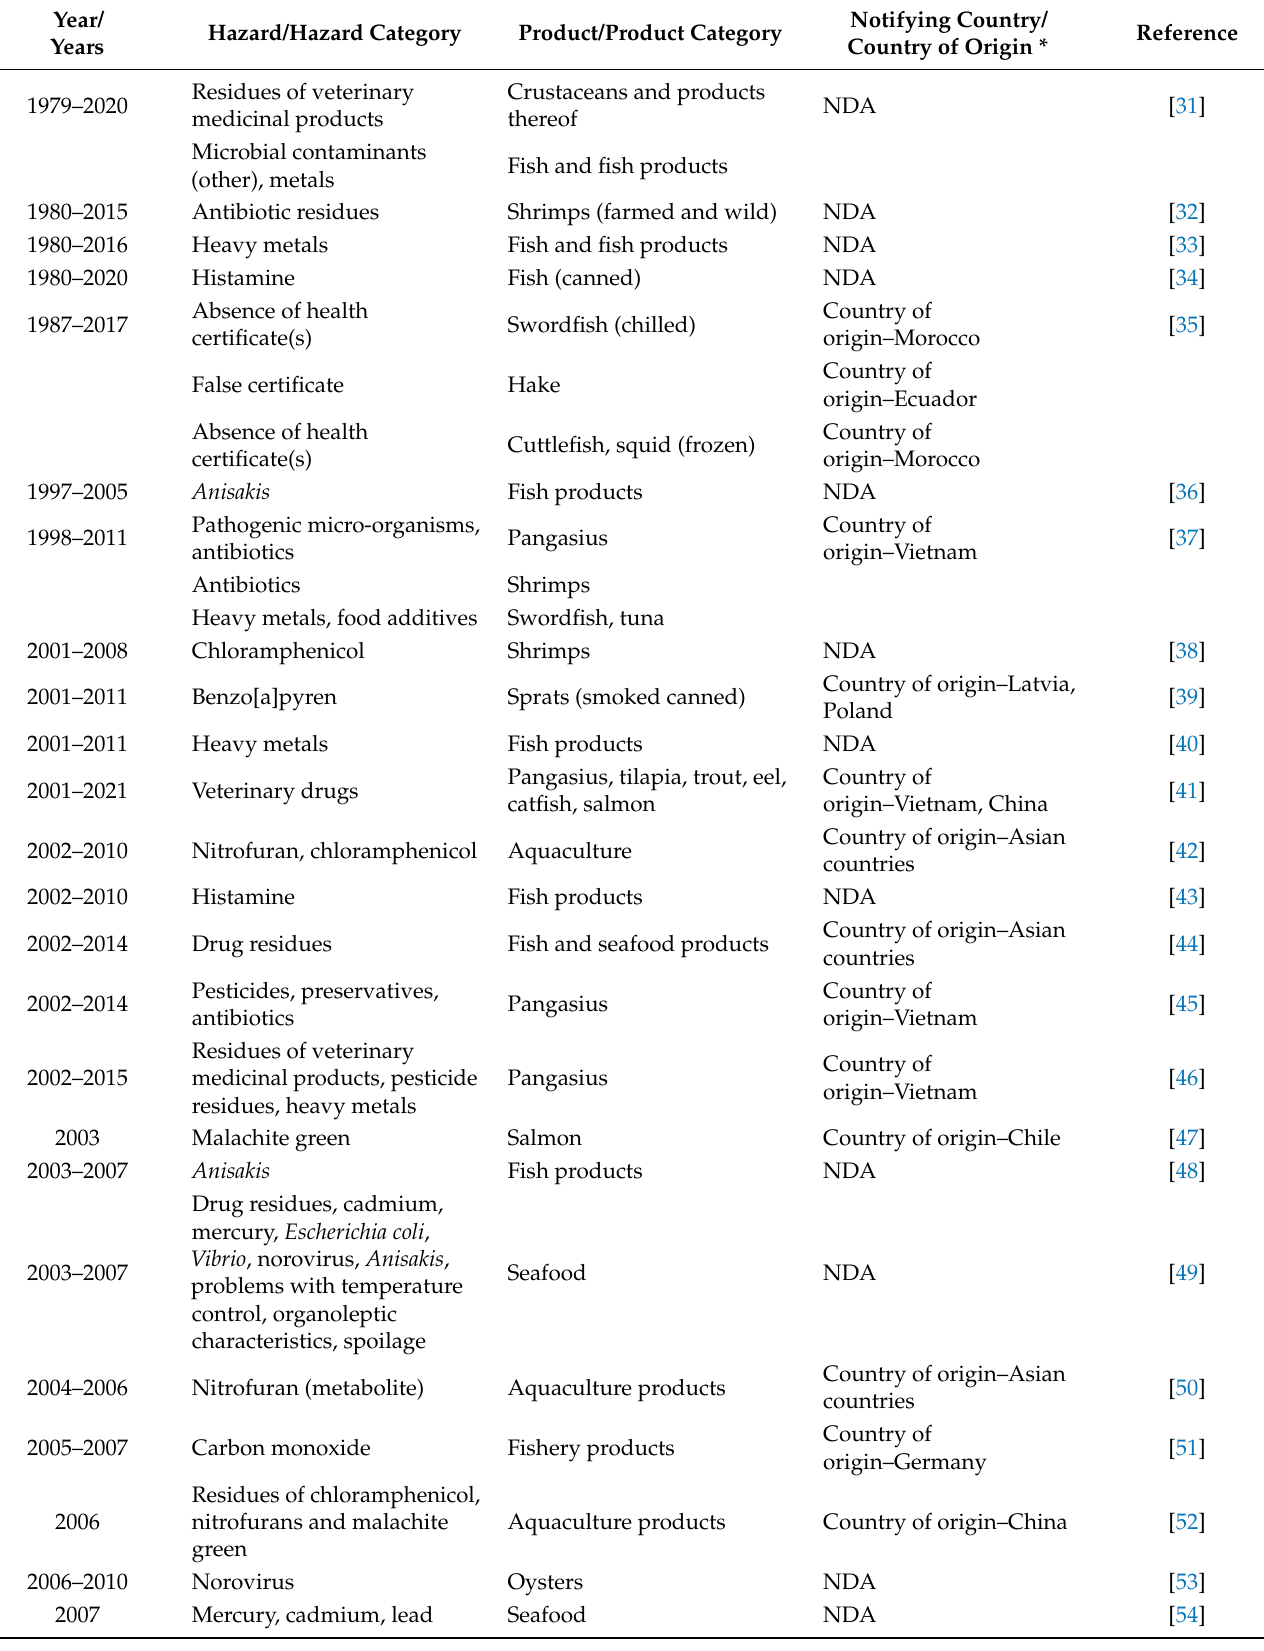
Table 14. Hazards on seafood notified in the RASFF by various authors for